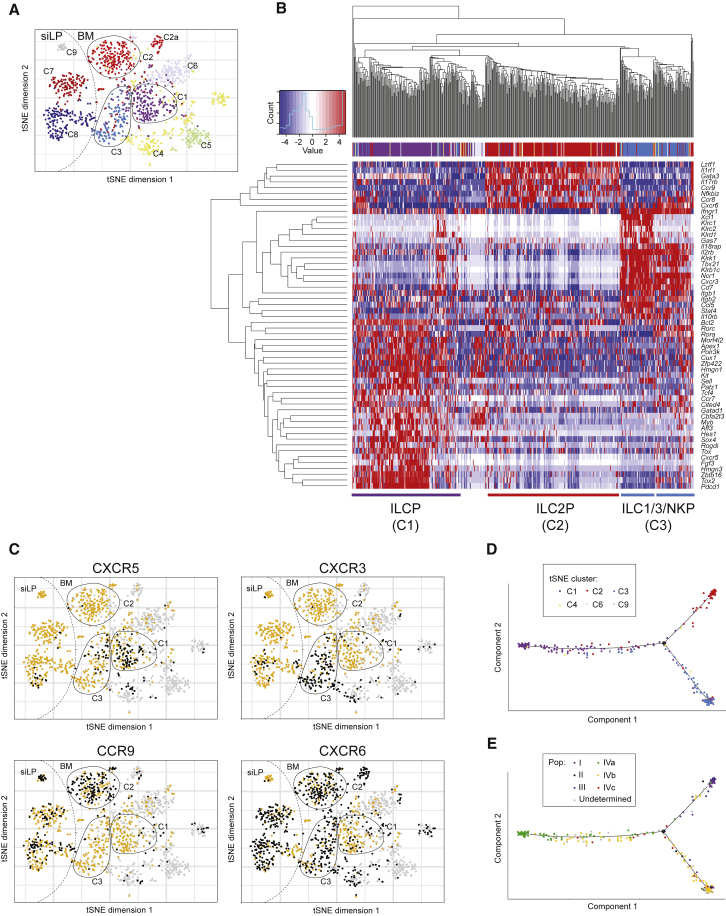
Single-Cell Analysis Identifies Divergence of ILC2P and Heterogeneous ILC3, ILC1, and NK Progenitors(A) tSNE plot of single-cell gene expression analysis from bone marrow and siLP cells (1,637 individual cells) purified from 5x polychromILC mice. Black circles highlight clusters C1–C3. Dotted line divides cells acquired from siLP (left) and BM (right).(B) Heatmap of selected genes differentially expressed between bone marrow cells not expressing Spi1, Gata1, or Sox13 (504 cells, predominately cells in clusters C1–C3).(C) tSNE plots of single-cell gene expression of chemokine receptors in the populations defined above in (A) and (B). Black dots indicate cells expressing > 5 normalized pseudocounts for the indicated gene; orange dots indicate cells expressing < 5 normalized pseudocounts for the indicated gene; and light gray dots indicate cells expressing Spi1, Gata1, or Sox13.(D) Cell trajectory from pseudotime analysis of a subset of bone marrow cells not expressing Spi1, Gata1, or Sox13 and sequenced with greater read depth (328 cells, predominately cells in clusters C1–C3). Shown is the trajectory from the early progenitor cells located in cluster C1 toward a bifurcation point at which the ILC2P cells (largely cluster C2) and the ILC3, ILC1, and NK cells (largely cluster C3) diverge.(E) Overlay of index-sorted cell phenotype onto the pseudotime trajectory shown in (D). Please also see Figure S7.